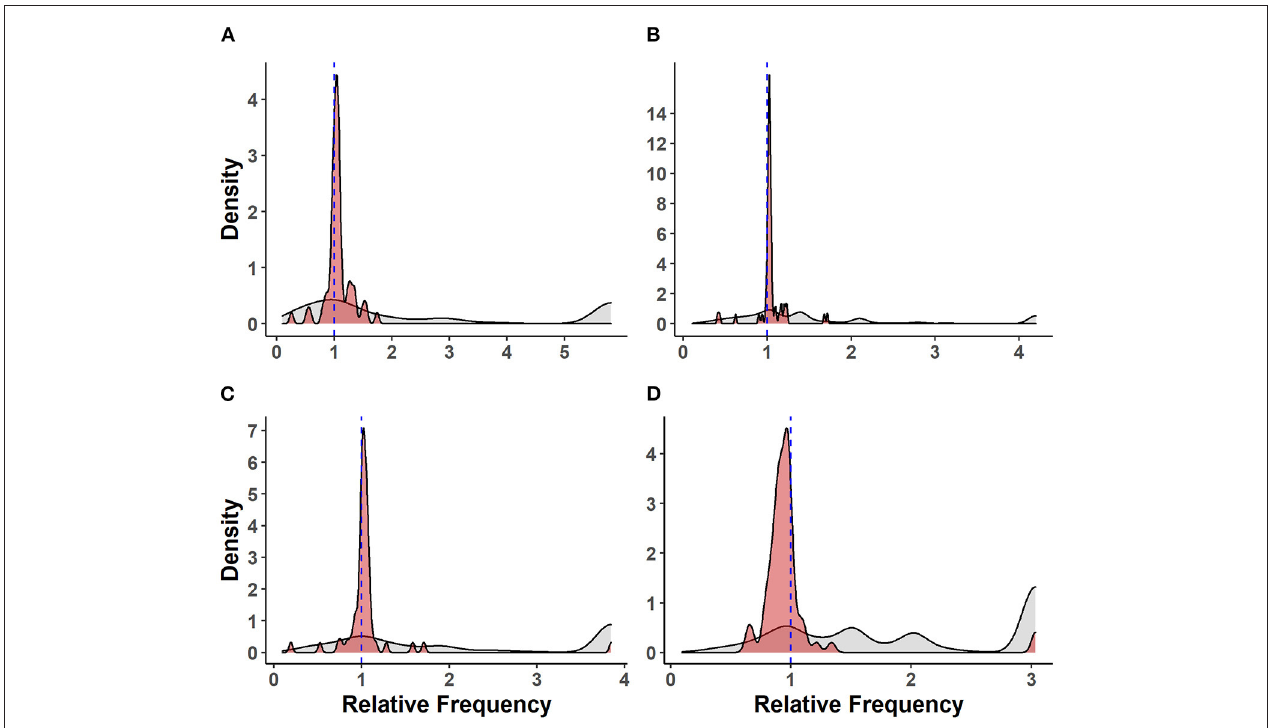
FIGURE 2 | Distribution of virulence-associated factor genes and other genes carried by 273 S. suis isolates. Density plots of relative frequencies of known/putative VAF genes (red) against all other genes (gray) carried by each isolate. A relative frequency > 1 denotes a higher prevalence of gene within isolate group; (A) isolates recovered from systemic sites of pigs with confirmed infections (SC), (B) isolates recovered from non-systemic sites of pigs with confirmed infections (NSC), (C) isolates recovered from probable infections (NSP), (D) isolates recovered from non-systemic sites of healthy pigs (NSH).